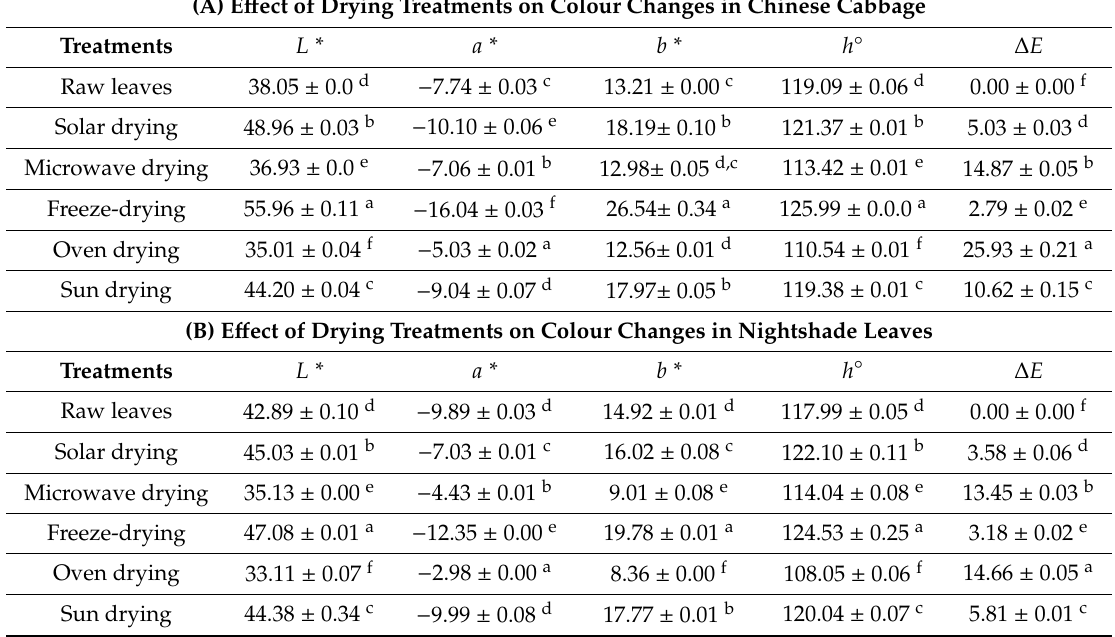
Table 1. E ff ect of drying treatments on colour changes in Chinese cabbage and Nightshade leaves. (A) E ff ect of Drying Treatments on Colour Changes in Chinese